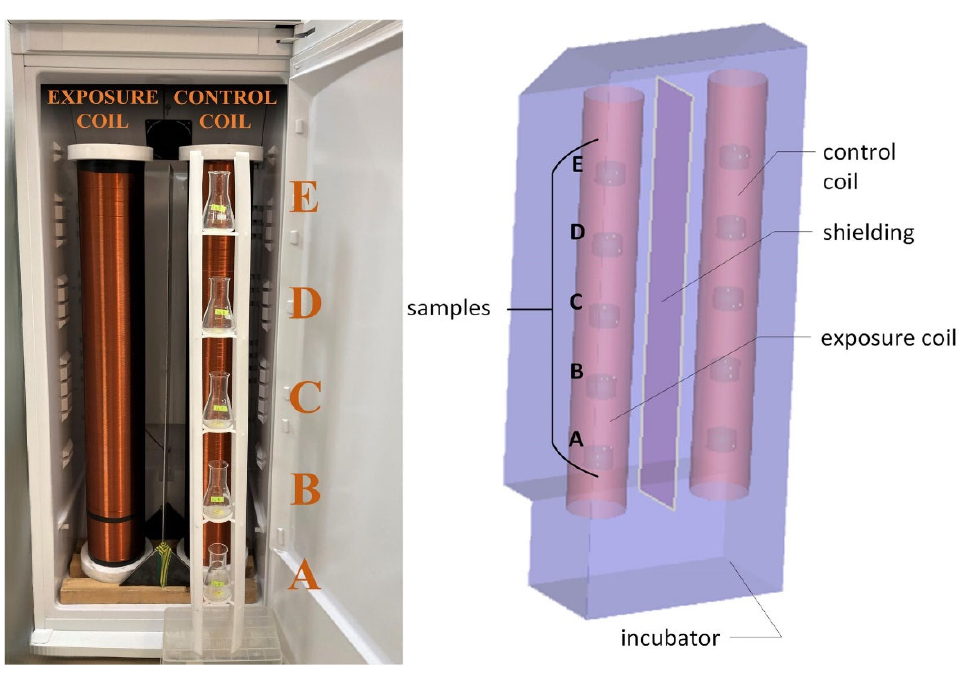
Figure 2. Exposure system. Letters A–E indicate exact position of each investigated